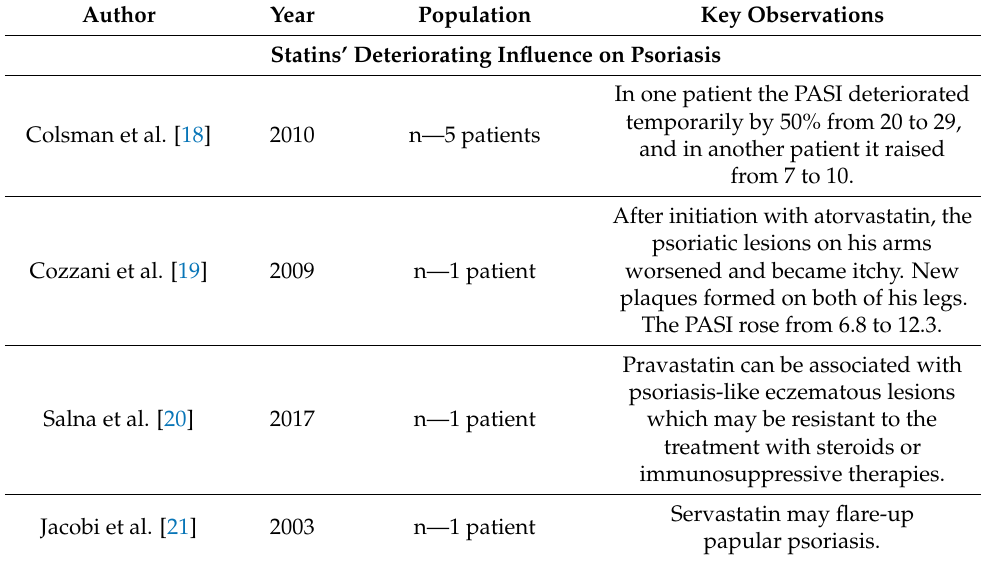
Table 5. Summary of the studies on statins’ deteriorating influence on psoriasis.